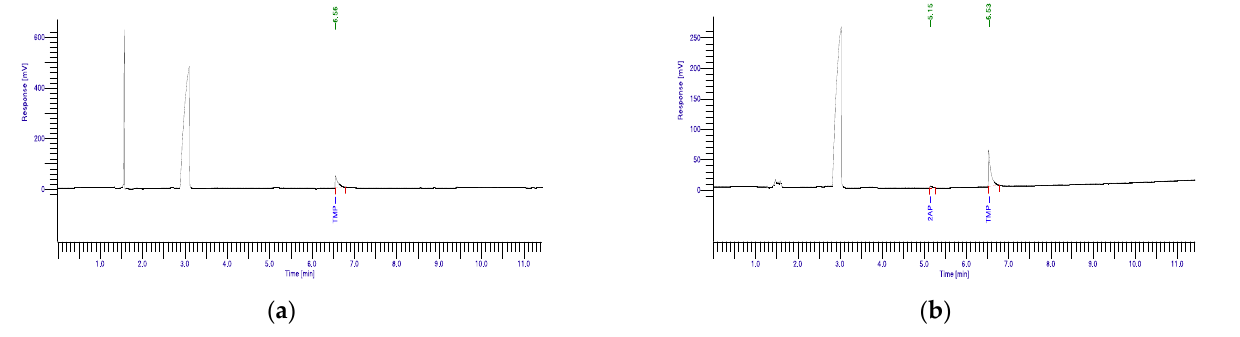
Figure 1. Chromatograms of GC–MS analysis of 2AP production for control nutrient broth without PGPR isolates ( a ) and Sinomonas sp. ORF15-23 ( b ). Table 2. 2-Acetyl-1-pyrroline (2AP) production by selected rhizobacterial isolates.